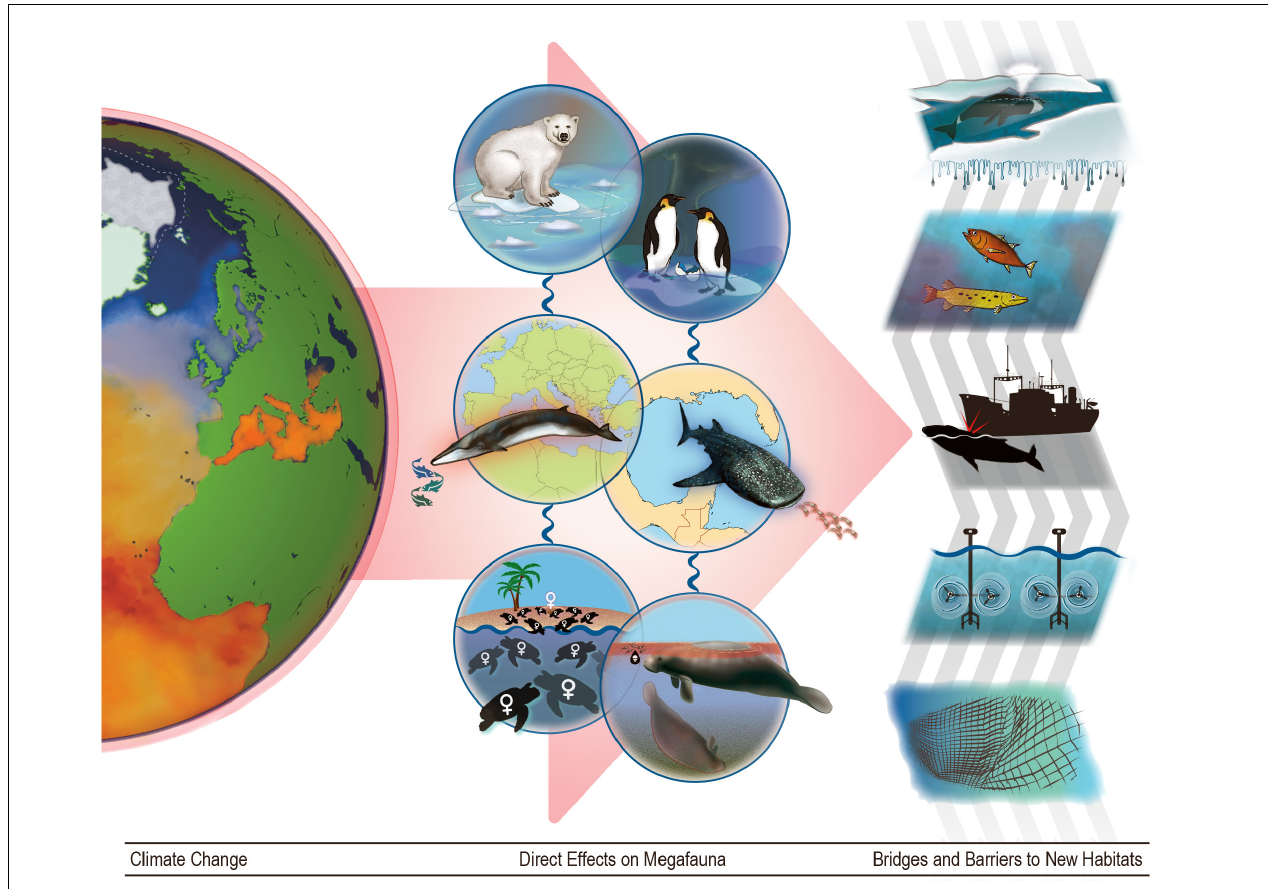
FIGURE 1 | The effects of climate change on marine megafauna. As climate change continues to affect the world’s ocean (column 1), the combined effects will push many species out of their current ranges (column 2) via three illustrative pathways each here represented by two case study species. From top to bottom: via loss of shelter (polar bears and emperor penguins), via range shifts in prey (Mediterranean fin whales and whale sharks), and via changing demographics due to effects on embryonic development (sea turtles) and increased exposure to toxins (sirenians). The third column shows some bridges and barriers that respectively facilitate or impede range shifts in megafauna: ice melt in the arctic, changes in water temperature along migration routes, interactions with ships, tidal mills, and fishing